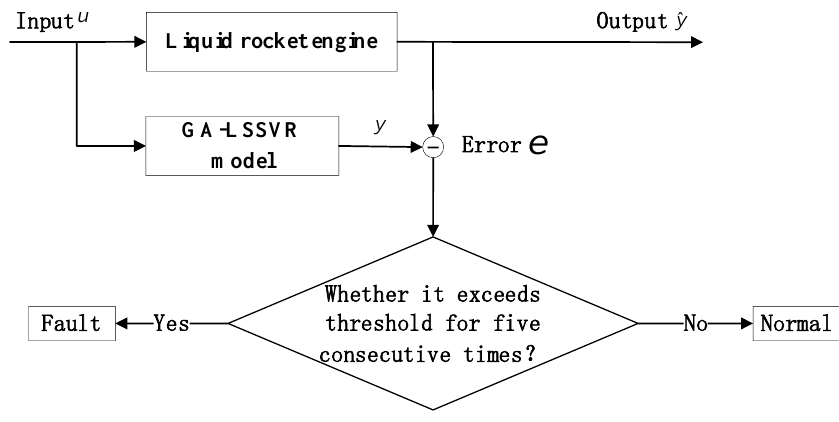
Figure 5. Fault detection flow of a liquid rocket engine based on GA-LSSVR.